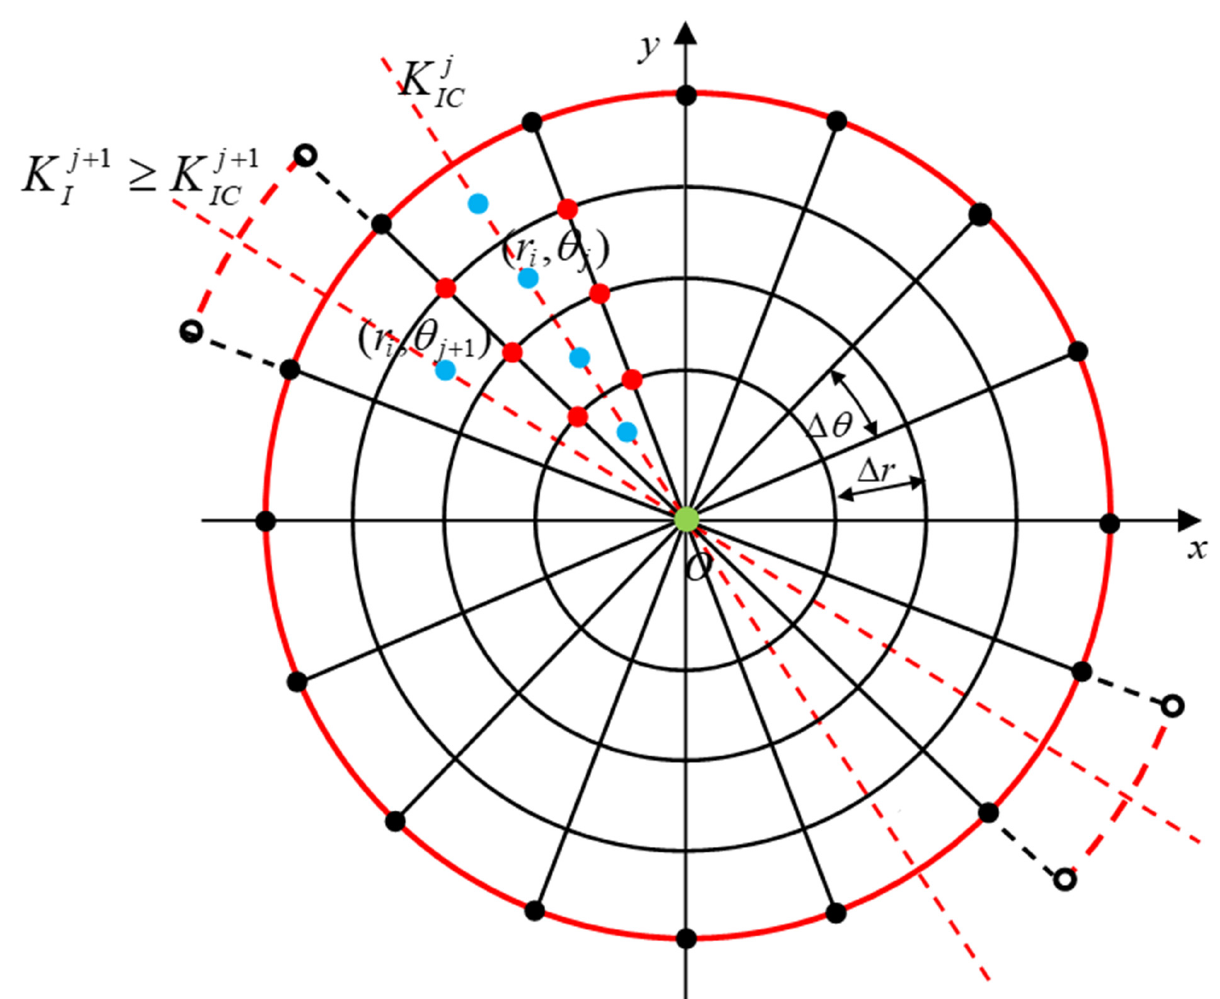
Figure 3. The discretized polar grid for the fracture. Black points–boundary grid nodes of the fracture front, red points–internal grid nodes, blue points–nodes of gravity center of elements and the green point is the wellbore. (𝑟 (cid:3036) , 𝜃 (cid:3037) ) and (𝑟 (cid:3036) , 𝜃 (cid:3037)(cid:2878)(cid:2869) ) are the elements’ coordinates. Subscripts “ 𝑖 ” and “ 𝑗 ” are the element number in the 𝑟 and 𝜃 directions, in which 𝑗 = 1, 2, 3, ⋯ , 𝑛 , and 𝑛 = 2𝜋 𝛥𝜃⁄ .